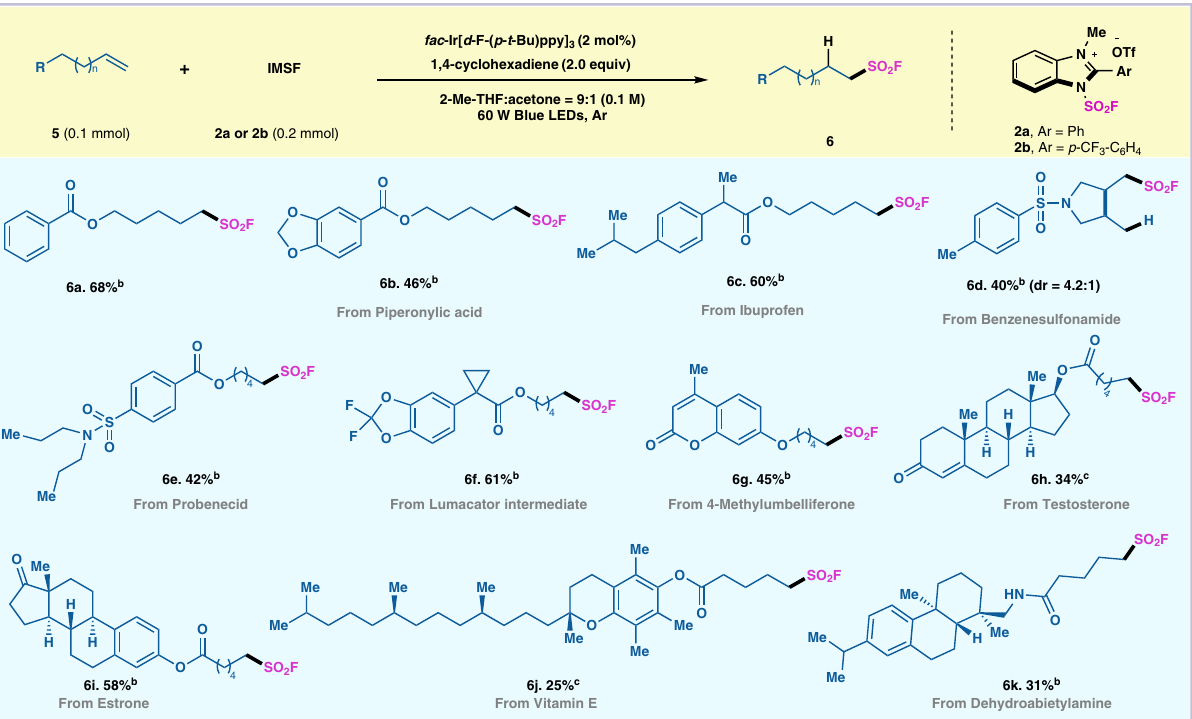
Fig. 3 Substrate scope of the radical hydro fl uorosulfonylation. All reactions were carried out with ole fi ns 5 (0.10 mmol), IMSF salt 2 (0.20 mmol, 2.0 equiv), fac -Ir( d -F-( p - t -Bu)ppy) 3 (2 mol%) and cyclohexa-1,4-diene (1.5 equiv) in 2-methyltetrahydrofuran:Acetone = 9:1 (1 mL) under Ar and 60 W blue LEDs. a. IMSF reagent 2a was used. b. IMSF reagent 2b was used.